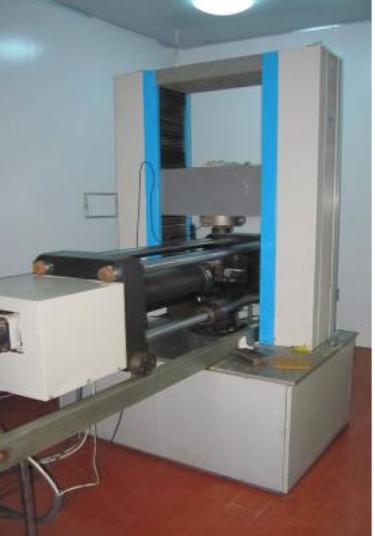
Figure 3. RYL-600 rock mechanics shear creep testing system.